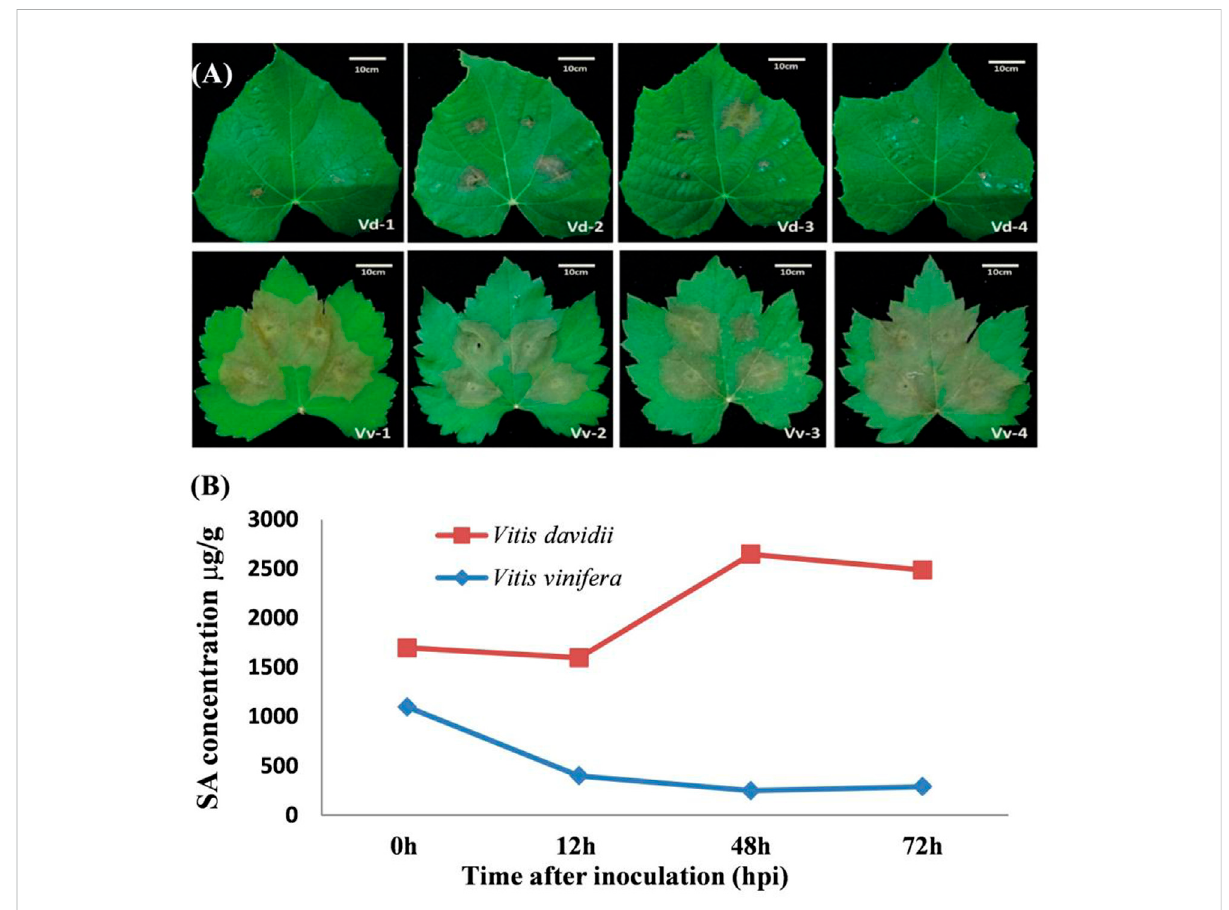
FIGURE 2 (A) Symptoms of Coniella diplodiella infection on the leaf samples of Vitis vinifera Manicure Finger (Vv) and Vitis davidii accession 0940 (Vd). Two-week-oldleaf sampleswerecollected at the3-4 position. Typical hypersensitiveresponse (HR) symptoms wereobserved in Vd but not inVv at 72 h post-infection (hpi). There were four replications of each species. (B) Endogenous measurementof SA from the V. davidii and V. vinifera after 0, 12, 48, and 72 h of white rot disease ( Coniella diplodiella )